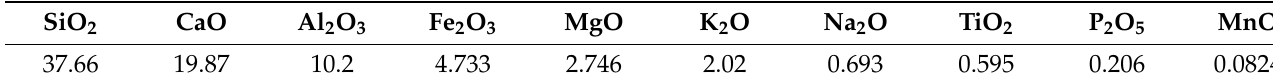
Table 3. Chemical composition of clay (wt.%).